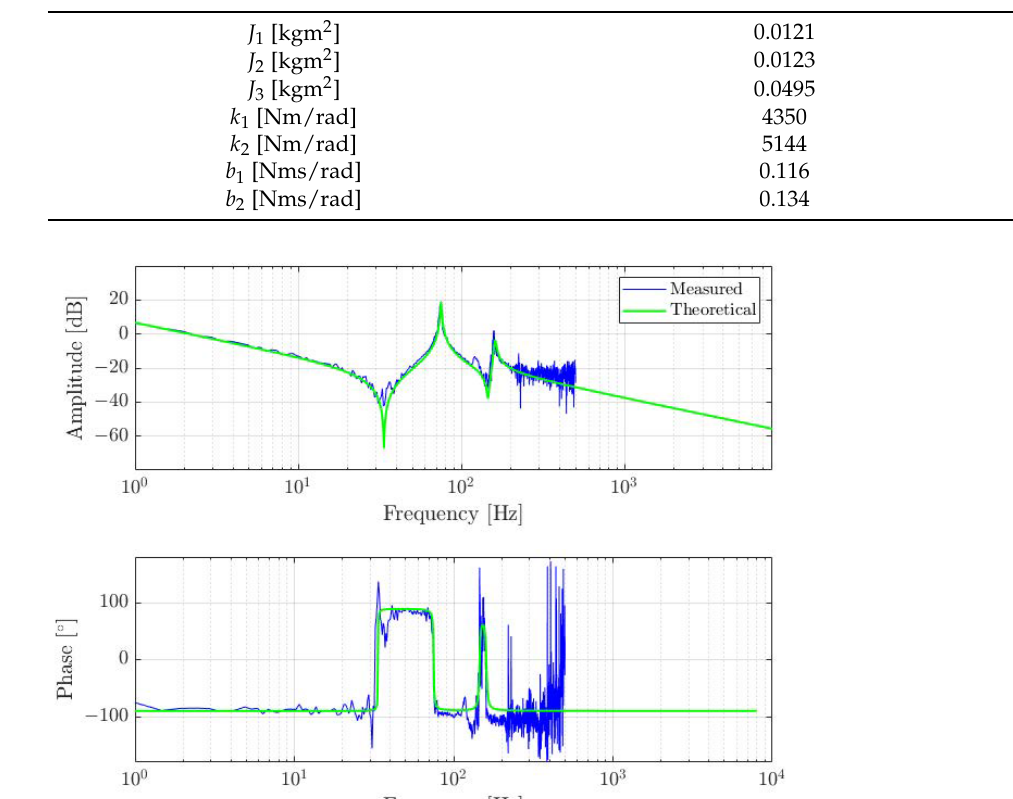
Table 1. Mechanical model parameters after identification.